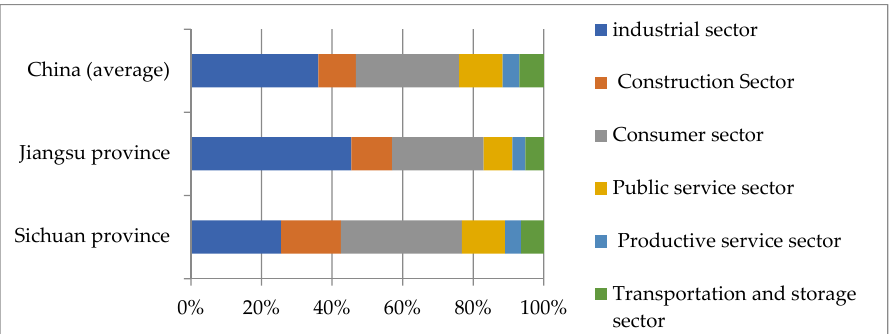
Figure 5. The schematic diagram of traditional and non-traditional urbanization mechanism.